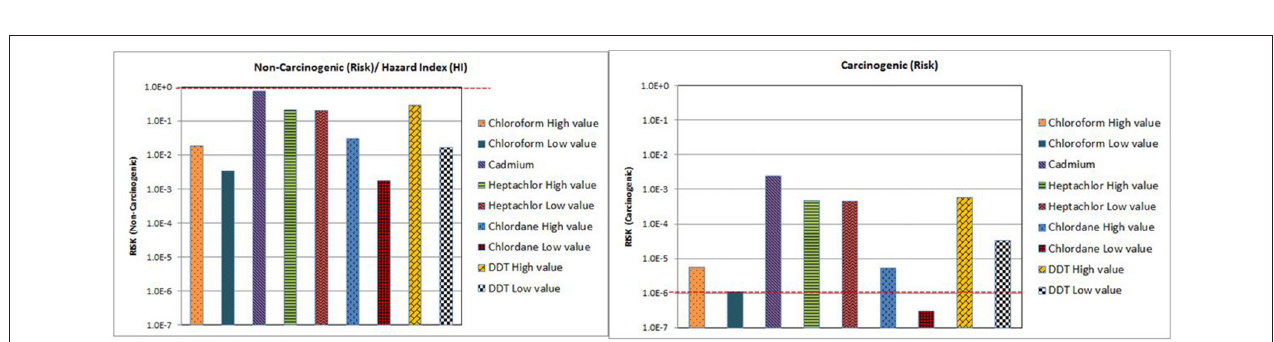
FIGURE 5 | Non-carcinogenic and carcinogenic toxicity scores of different contaminants/adulterants.